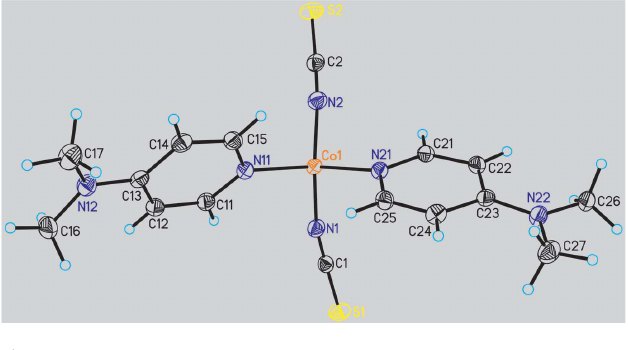
Figure 2 Crystal structure of form II with labeling and displacement ellipsoids drawn at the 50% probability level.